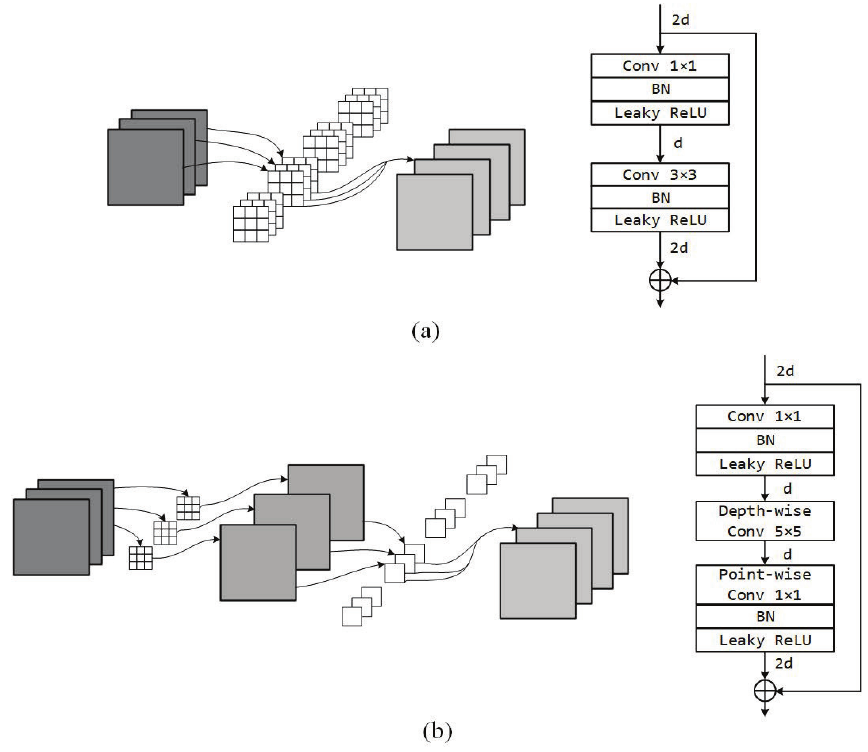
Figure 4. Convolution and residual blocks. ( a ) denotes the standard convolution and residual block used in YOLOv3 [37], and ( b ) denotes the separable convolution and our advanced “Separable Residual